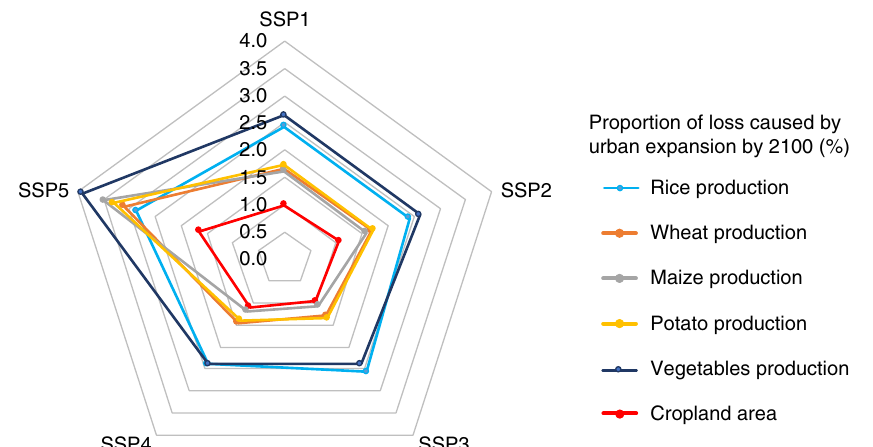
Fig. 8 Estimated cropland and food production losses caused by urban expansion by 2100. Comparing to the approximately 1% loss in the global cropland area caused by future urban land expansion, the direct losses of global crop production are likely to exceed 1%, and can even reach as high as 4%, depending on the speci fi c crop types.